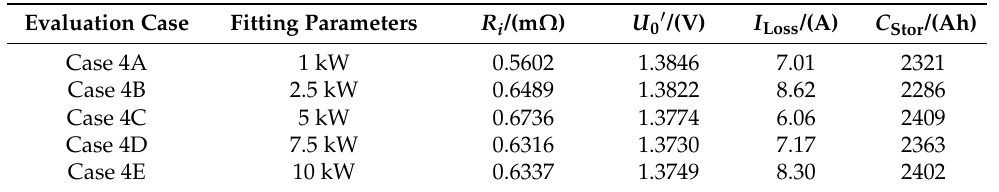
Table 2. Optimal model parameters for power specific parametrization.